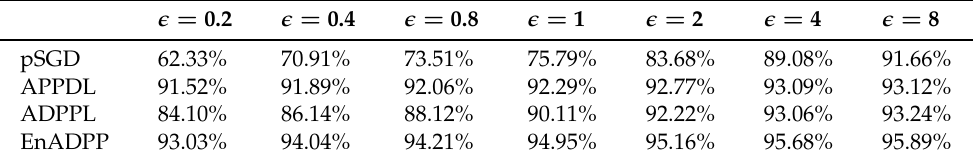
Table 1. The accuracy of EnADPP framework and comparison methods on MNIST dataset.